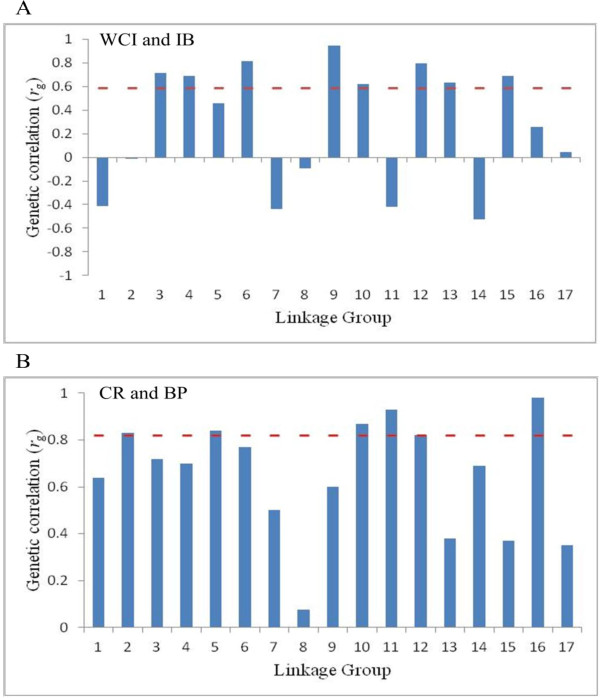
Linkage group-level and whole genome-level (the dotted horizontal red line) estimated genetic correlation (rg) between two pairs of traits. A: weighted cortical intensity (WCI) and internal browning (IB); B: fruit splitting (CR) and bitter pit (BP).